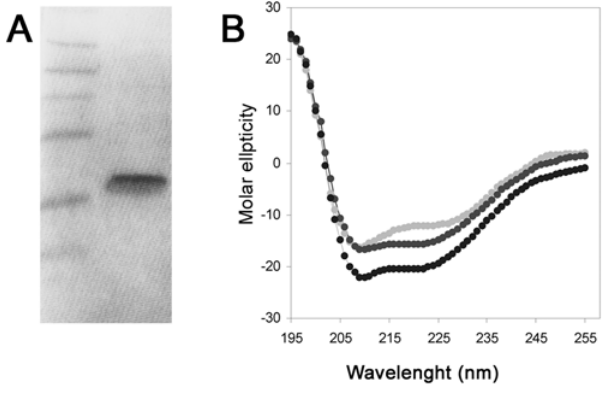
Figure 2. Circular dichroism of CIII. ( A ) 200 pmol of purified His 6 -CIII (right lane) were loaded on 4–12% NuPAGE (invitrogen) and visualized by Coomassie staining. On the left lane protein size marker was loaded (sizes 49, 38, 28, 14, 6 and 3 kDa). ( B ) The Circular dichroism spectrum (wavelengths 195–255 nm) of the purified His 6 -CIII at 3.5 m M (light gray), 27 m M (dark gray) and 40 m M (black).